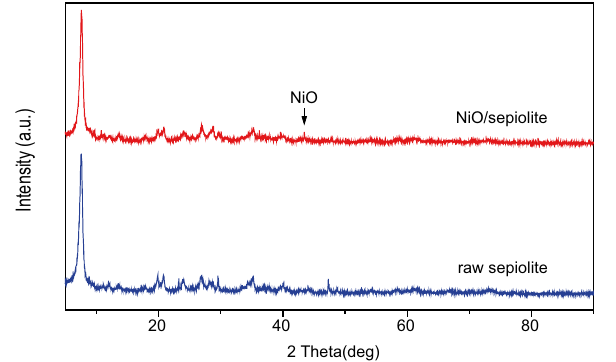
Figure 1. XRD patterns of NiO-sepiolite and raw sepiolite.